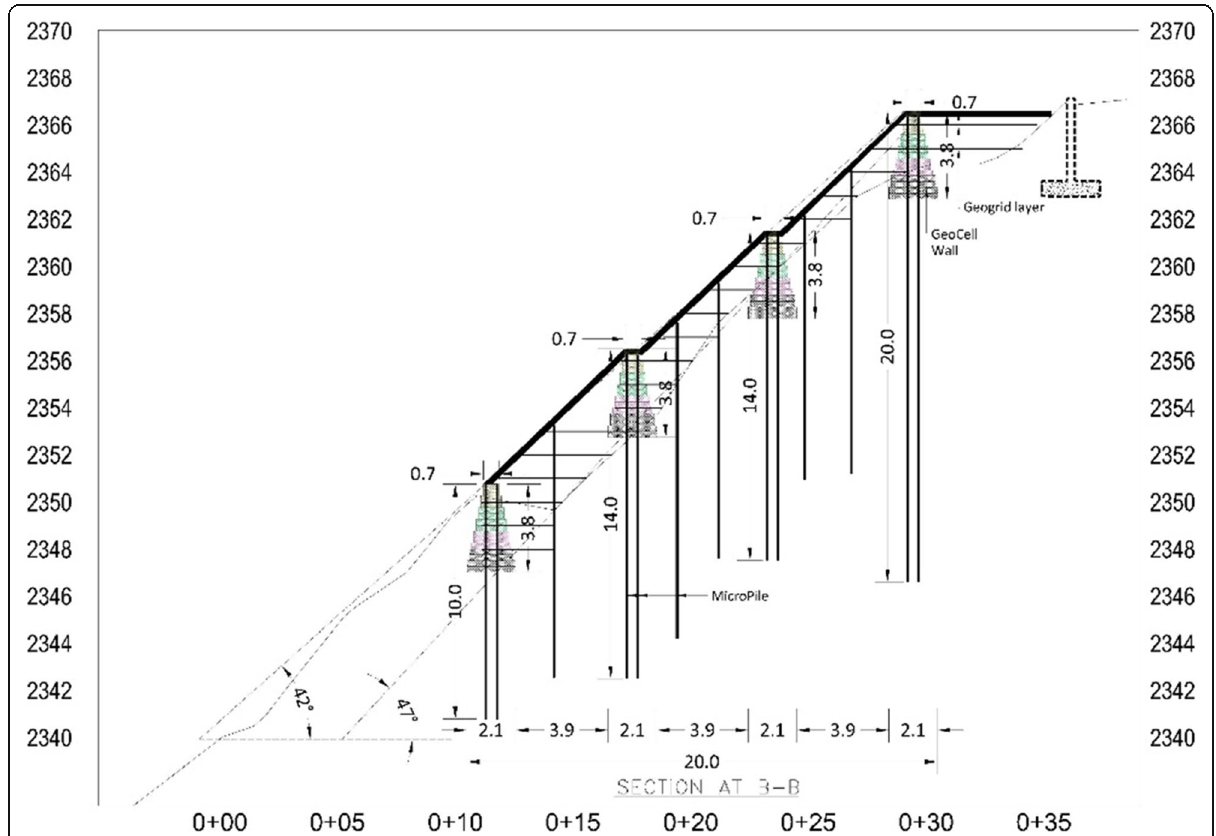
Fig. 10 Schematic diagram at section B-B, showing installation of micropile, geocell wall and geogrid